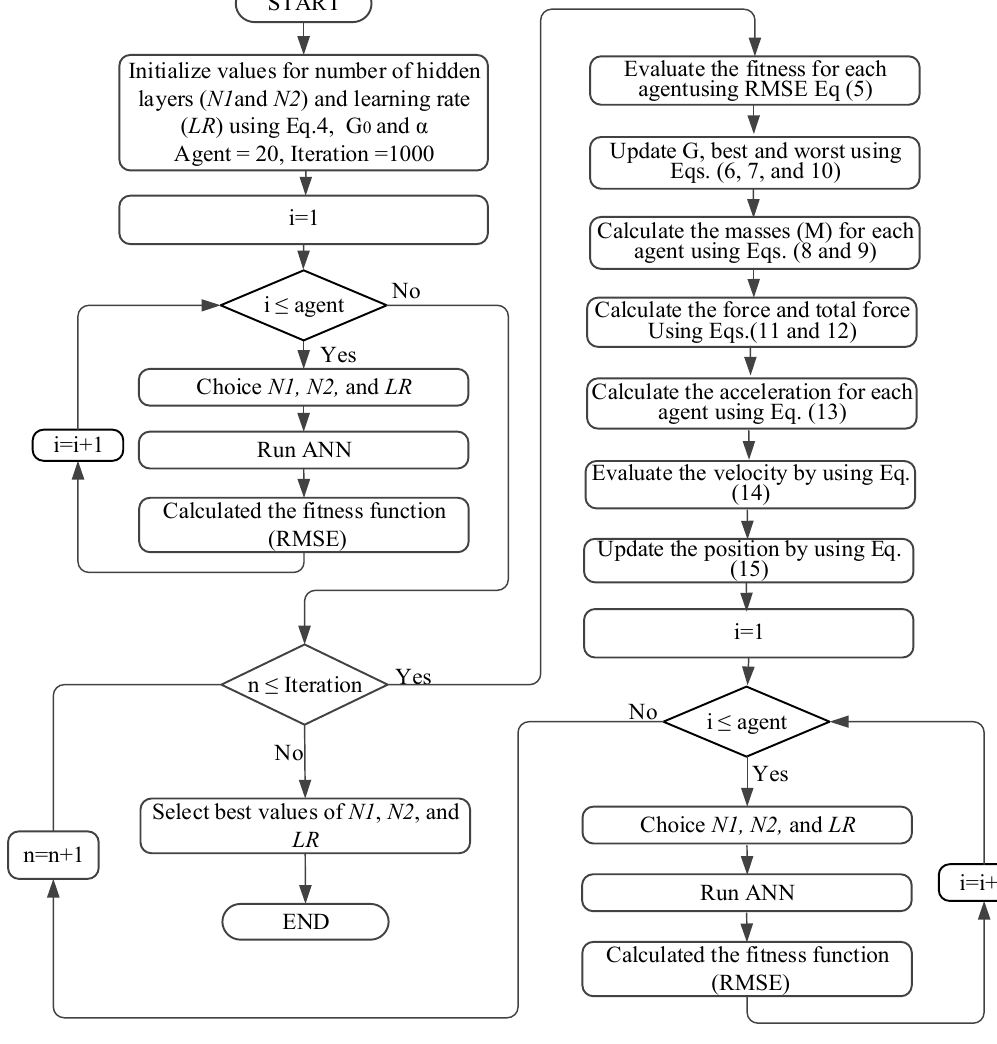
Figure 9. Flow chart of hybrid GSA-ANN.